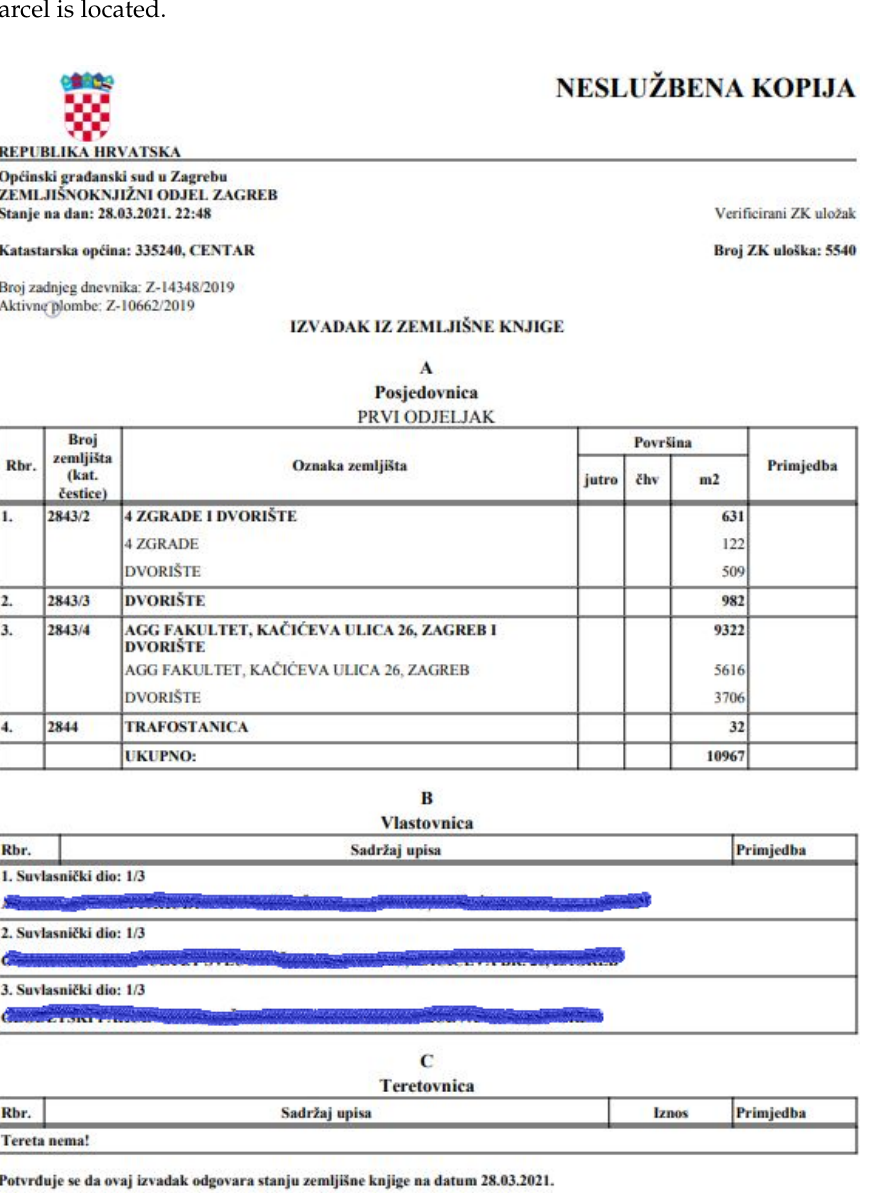
Figure 5. Land Book extract. Source: [29].